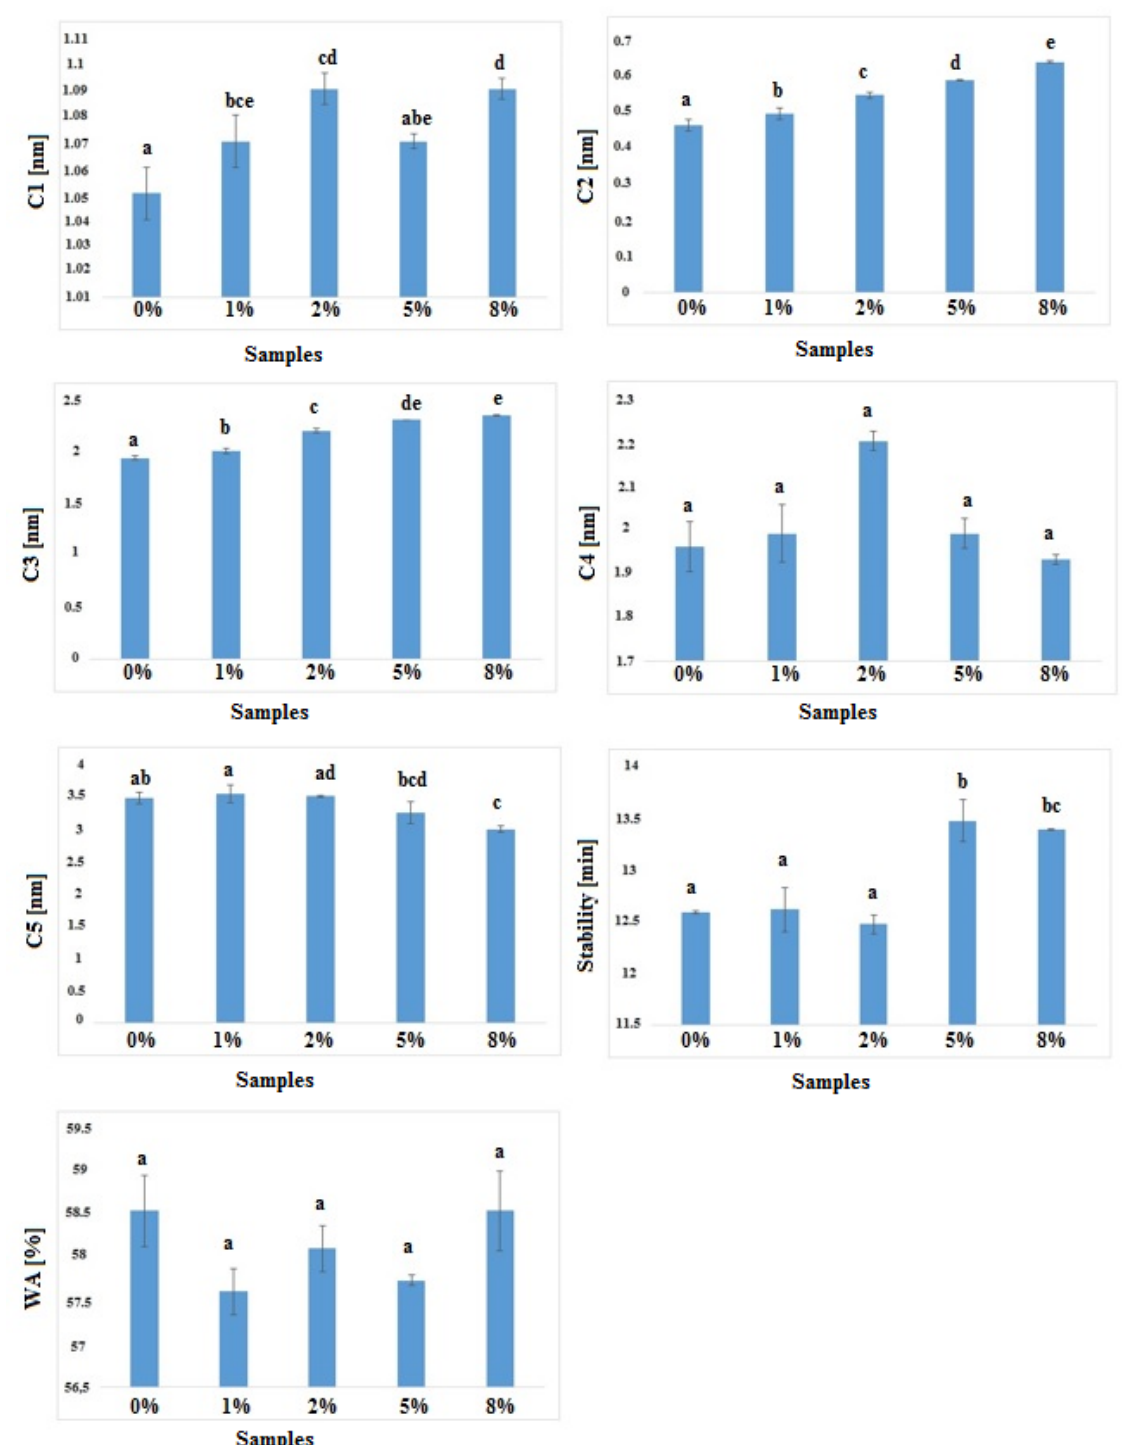
Note: Values are expressed as means of three determinations ± standard derivation. Different letters in the columns indicate significant differences (P < 0.05) between the experimental groups Figure 1: Thermo-mechanical characteristics of the experimental flours (C1: maximum consistency obtained in the first 8 min; C2: protein weakening related to mechanical work and temperature; C3: gelatinization of starch, stability of hot gel; C4: retrogradation of starch in the cooling phase; C5: time until the torque at the point C1 decreases in 11%; WA: the amount of water taken up by